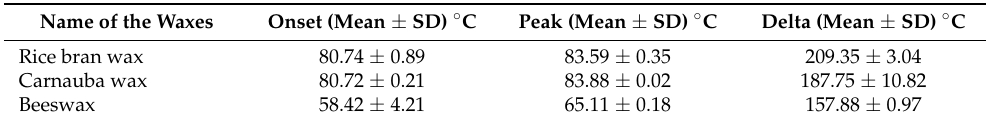
Table 1. Melting profile of the three selected waxes.